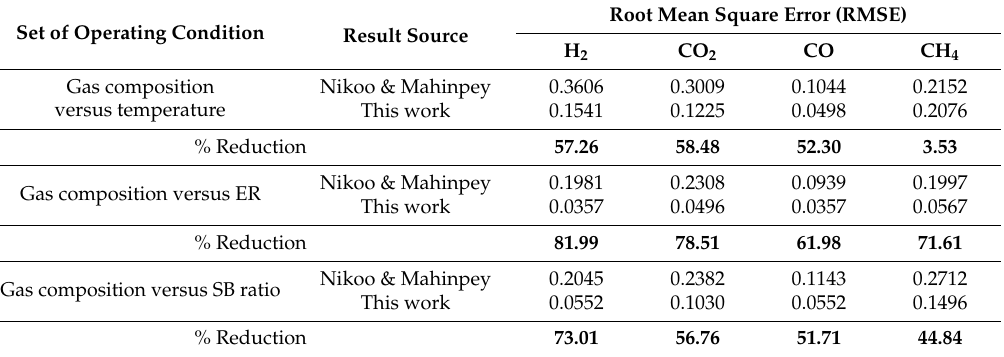
Table 3. The root mean square error of simulation results obtained from Nikoo & Mahinpey [14] and this